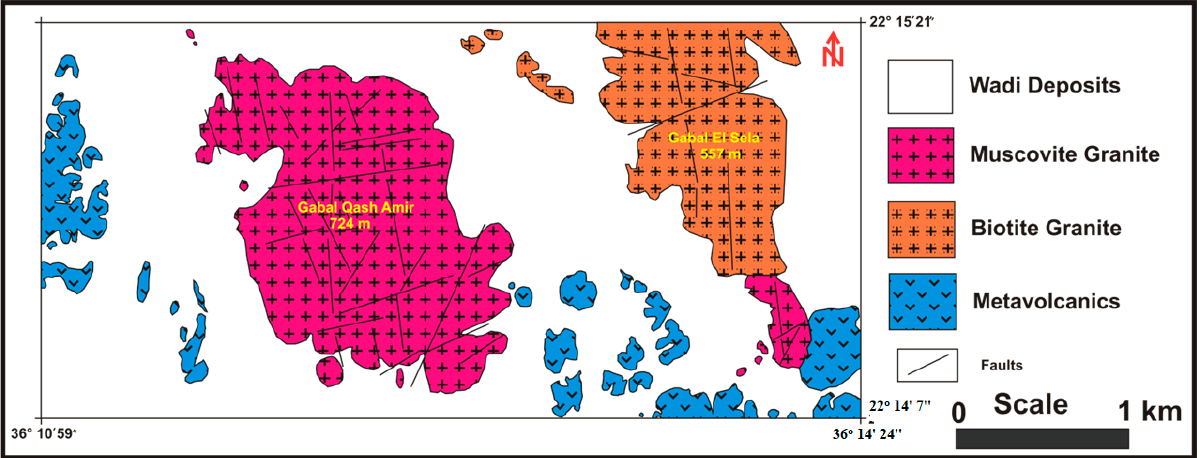
Figure 2. Geological map of the Gabal Qash Amir area, south Eastern Desert, Egypt.